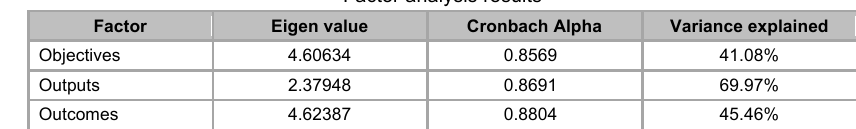
Factor analysis